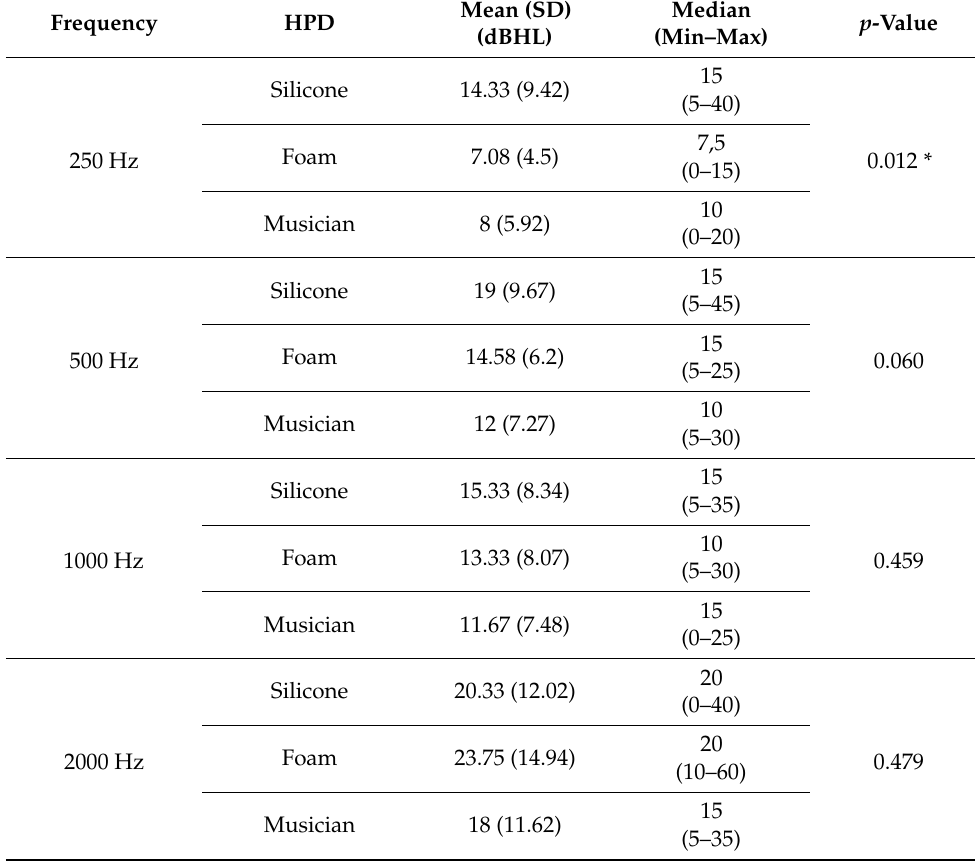
Table A1. Analysis of variance in attenuation levels (obtained with REAT) between the three HPD